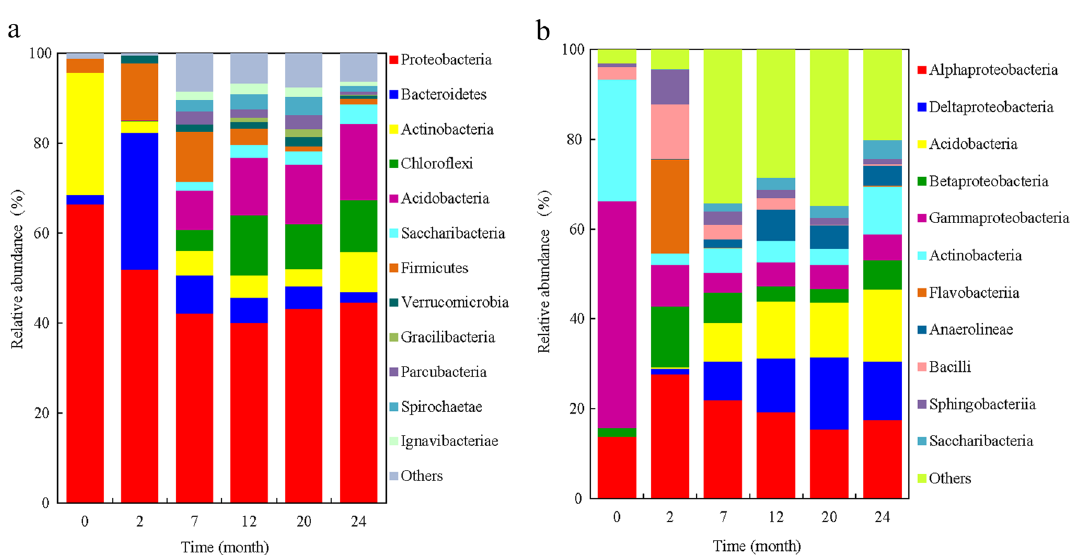
Figure 5. Changes in phylum ( a ) and class ( b ) levels of bacterial community composition during straw